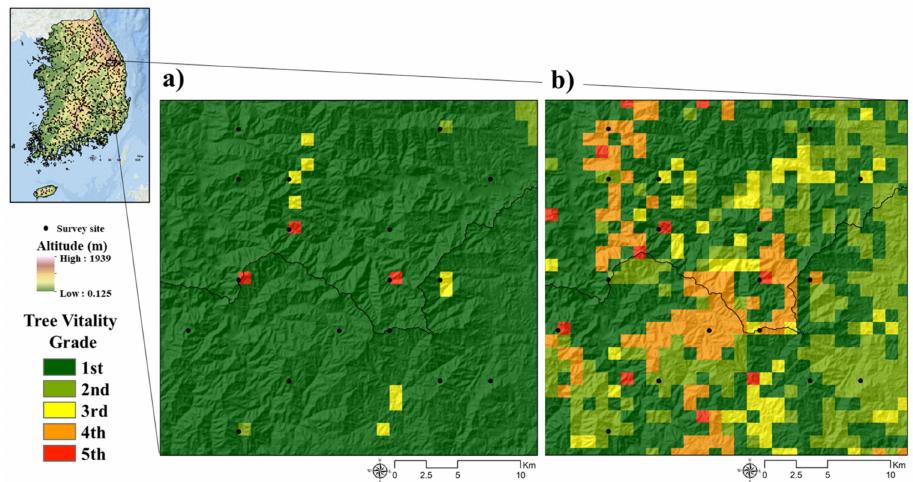
Figure 6. RF ( a ) and MME ( b ) tree vitality maps